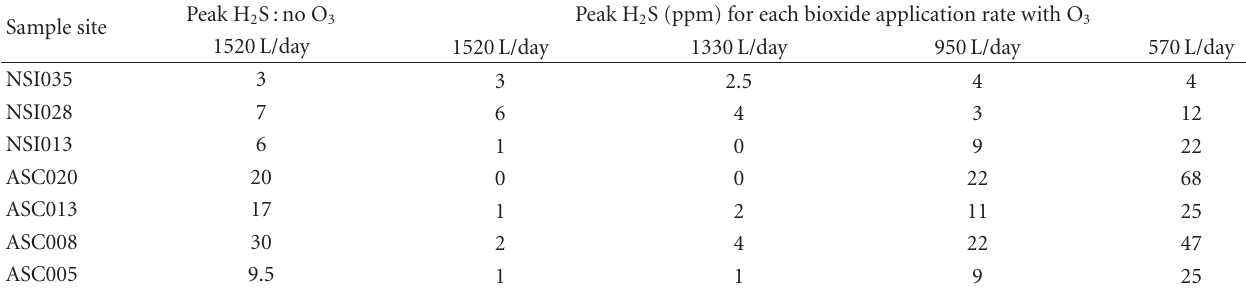
Table 4: Peak hydrogen sulfide gas as a function of Bioxide addition at sample sites downstream of Fox River Fiber. Sample